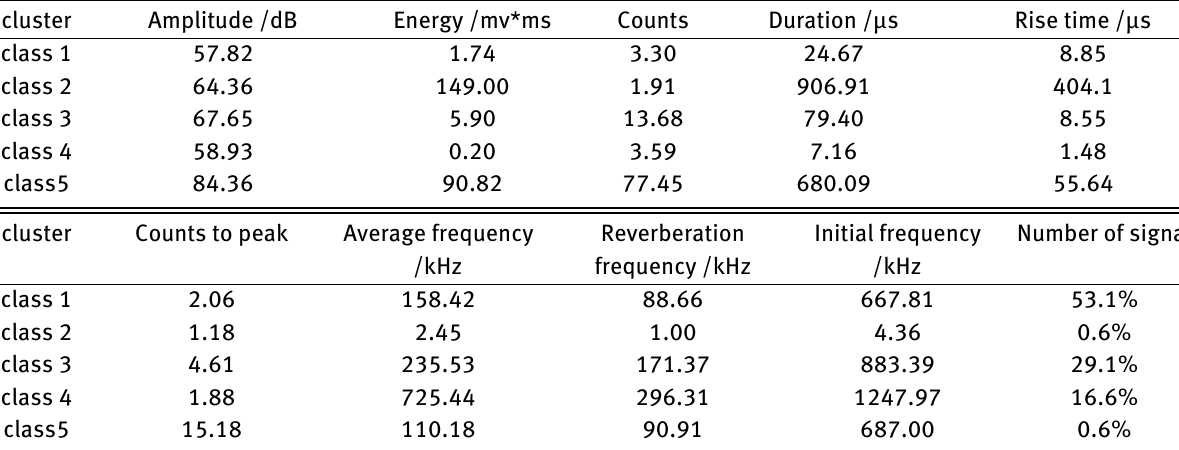
Table 7: Average value of AE parameters per cluster for In-situ tensile test cluster